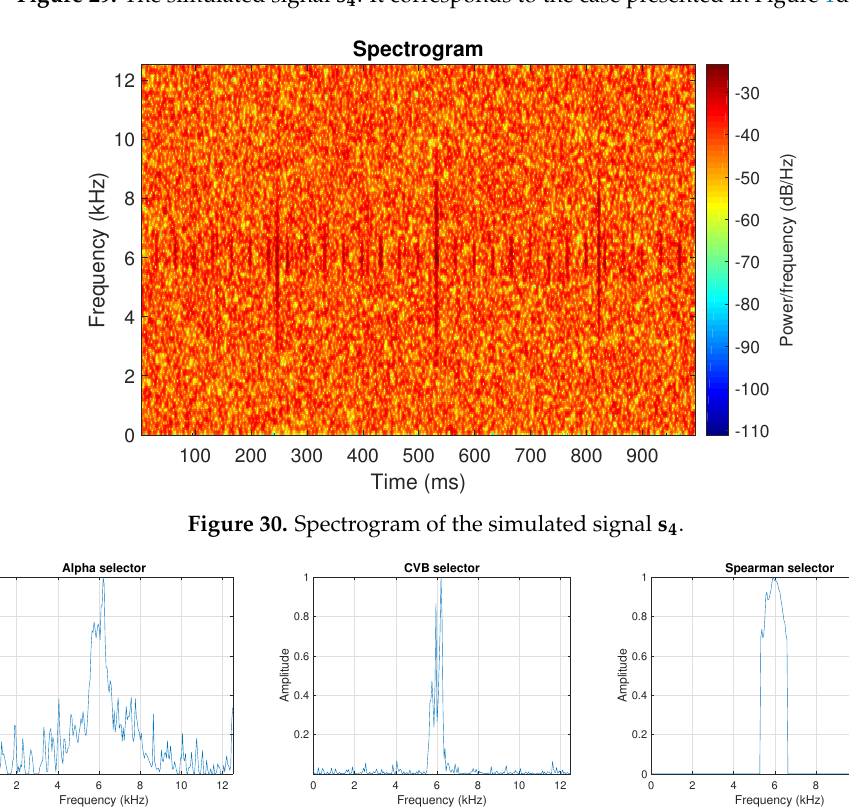
Figure 29. The simulated signal s 4 . It corresponds to the case presented in Figure 1d.